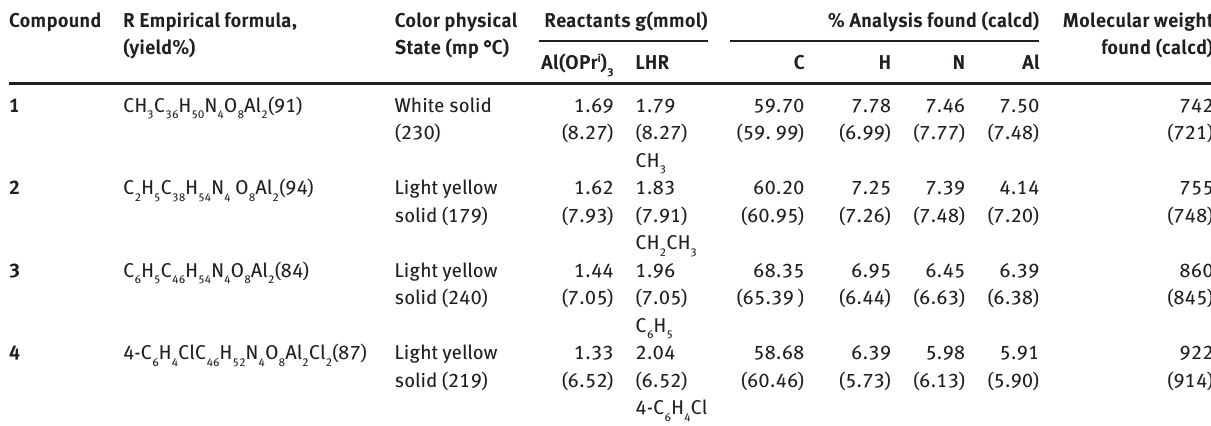
i ) µ -OPr i ) . 3 ] 2 Al( 2 Al(OPr 2